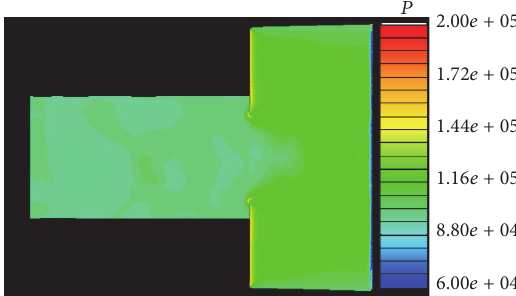
Figure 6: Computed surface pressure contours between the fins in the wind side, 𝑀 = 2.5, 𝛼 = 0 ∘